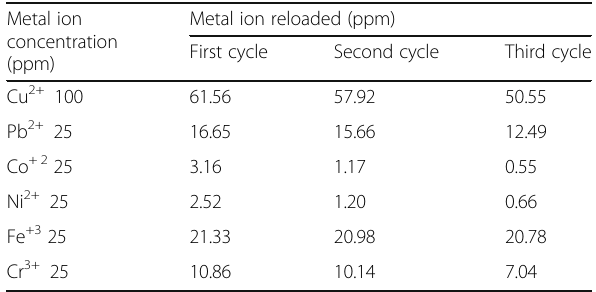
Table 3 Metal ions reloading by regenerated biomass Metal ion